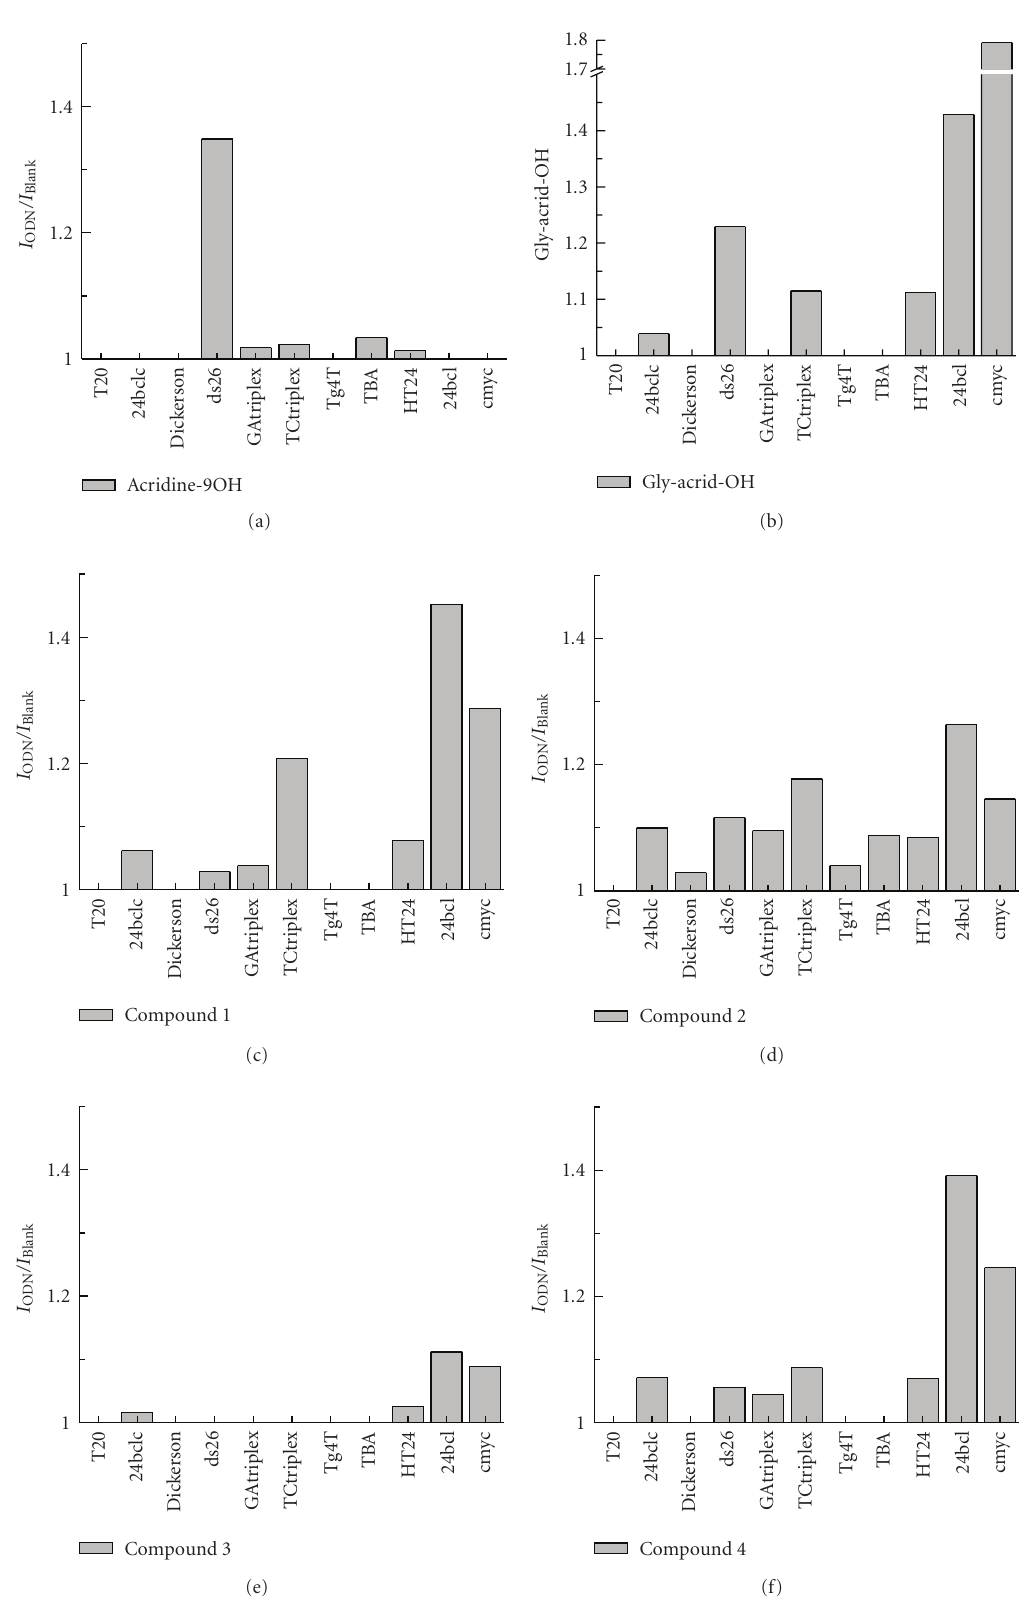
Figure 3: Results obtained by the competitive dialysis assay. The amount of ligand bound to each DNA structure is shown as a bar graph. The fluorescence of each sample was measured using an excitation wavelength of 252 nm and an emission wavelength of 435 nm,